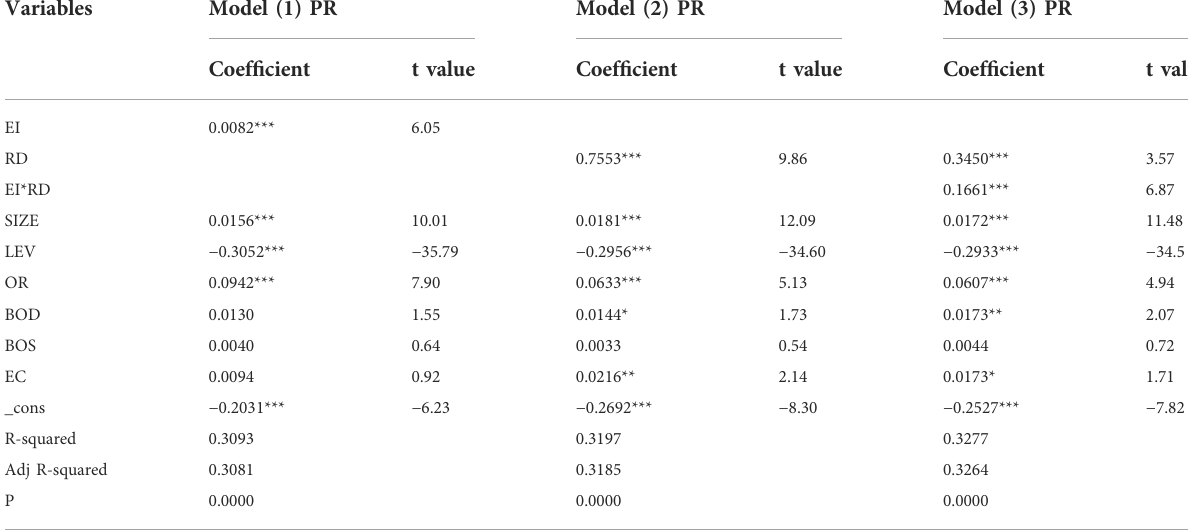
TABLE 4 Results of OLS mixed